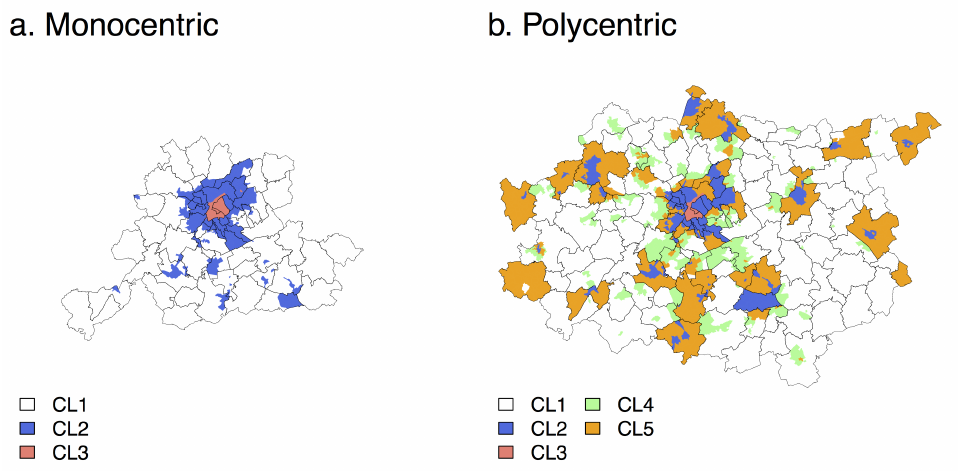
Figure 4: Cluster of Statistical wards by predicted probability of location at different scales